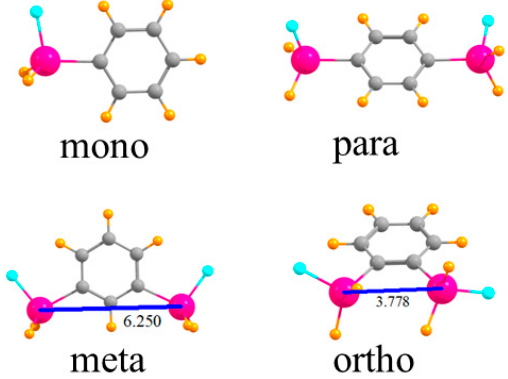
Figure 1. Geometries of mono- and disubstituted SnFH 2 phenyl rings. Distances in Å. 121